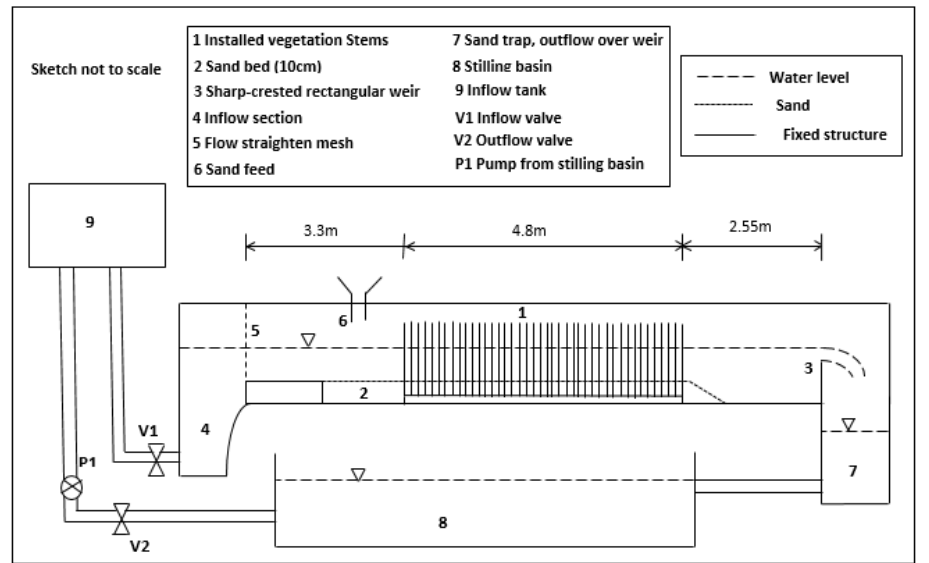
Figure 3. Vegetation stems arrangement. Two groups of weakly non-uniformly-sized sediment with mean sizes d 50 = 0.45 mm and 1.6 mm, were used. The standard deviations of sediment mixtures defined as 5.0 1684 )/( dd g   , were 1.47 and 1.35 for sediment sizes of 0.45 mm and 1.6 mm, respec- tively. Sediment mixtures with the value of g  less than 1.6 are considered as weakly non-uniform [24]. The density of sediment, s  , is equal to 2650 kg/m 3 . Before each experi- mental run, sediment was saturated and placed evenly on bed surface at a depth of 10 cm (Figure 2). 2.2. Water and Bed Slopes Flow depth was measured at an interval of 0.45 m along the vegetated reach using a fine-scaled ruler of 1 mm accuracy. When the measured flow depths were nearly constant along the measurement reach (~4.8 m), the flow was nearly quasi-steady and quasi-uni- form. Each experimental run was typically about 5–6 h. After each experiment, bed eleva- tions were measured by a laser level (accuracy 1 mm) at an interval of 0.45 m in the stream- wise and 0.1 m in the transverse directions within the vegetated reach. Bed elevation at